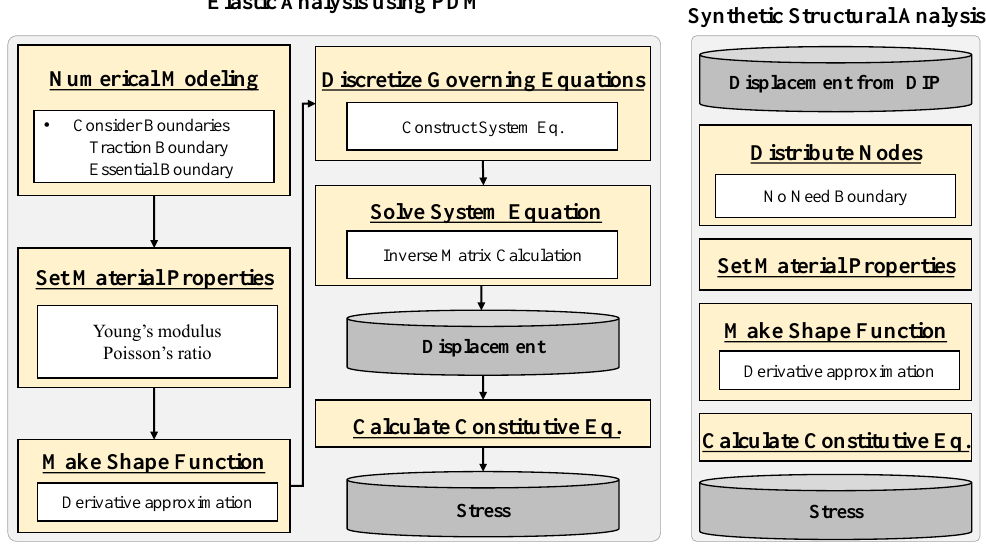
Figure 8. Comparison of the particle difference method (PDM) process between the elastic analysis and synthetic structural analysis.